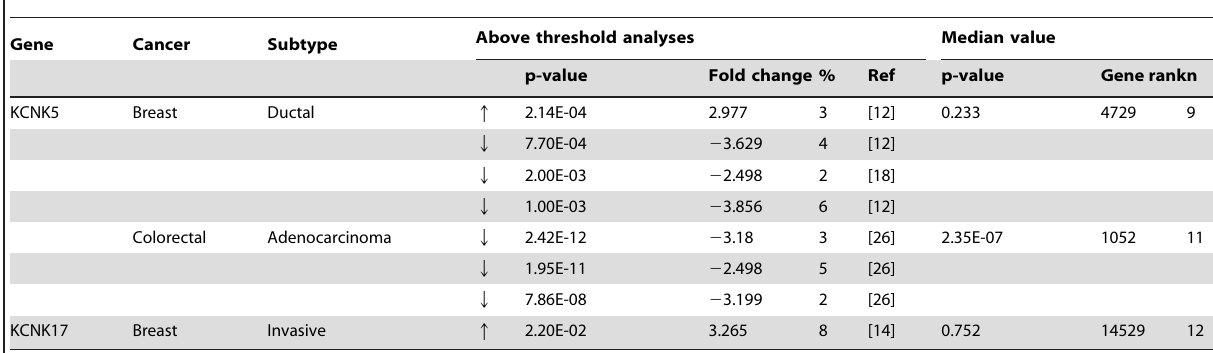
Table 5. TALK family members expression in cancer.